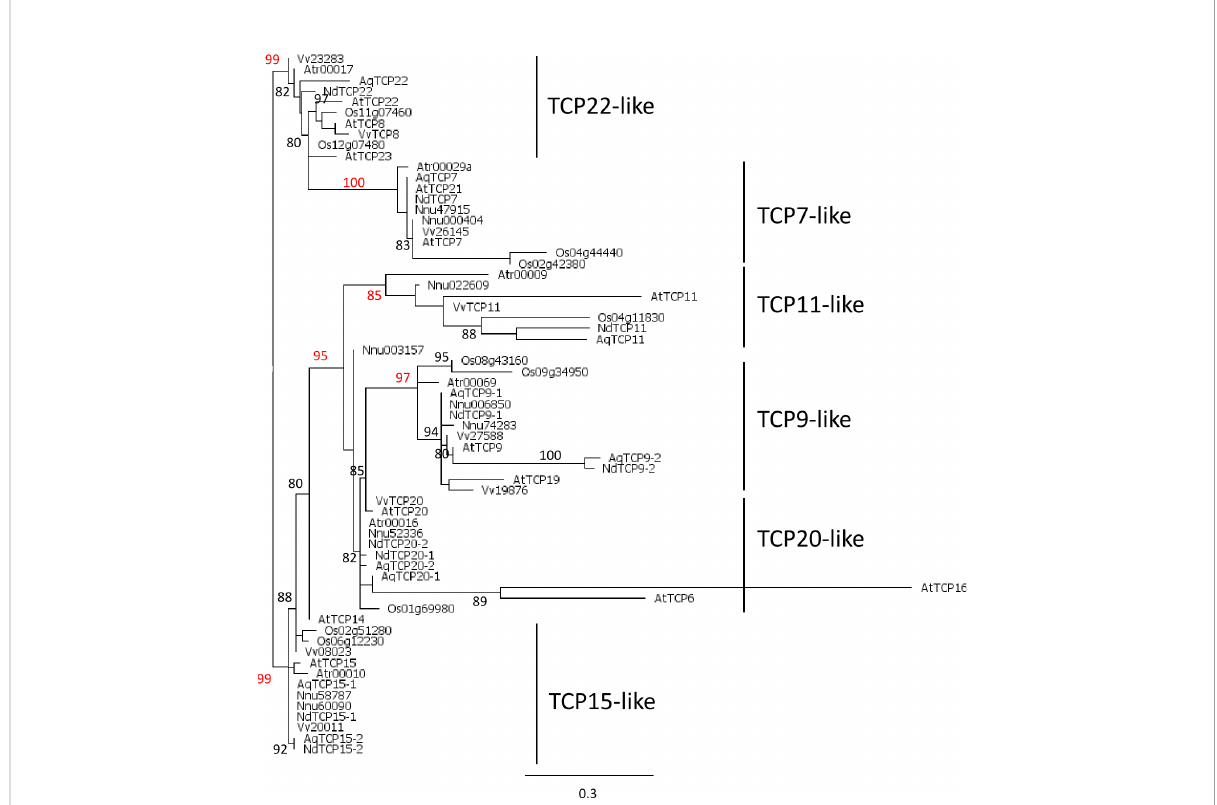
FIGURE 1 Phylogeny of class I TCP proteins in the complete inferred proteomes of Amborella trichopoda (Atr), Arabidopsis thaliana (At), Vitis vinifera (Vv), Nelumbo nucifera (Nnu), Aquilegia coerulea (Aq), Oryza sativa (Os), and the nine proteins deduced from the fl oral trancriptome of Nigella damascena (Nd). Maximum likelihood reconstruction was done with PhyML based on the alignment of 69 amino acid positions that included the TCP domain. Branch support values above 80% are indicated (a-LRT x100) with those discussed in the text in